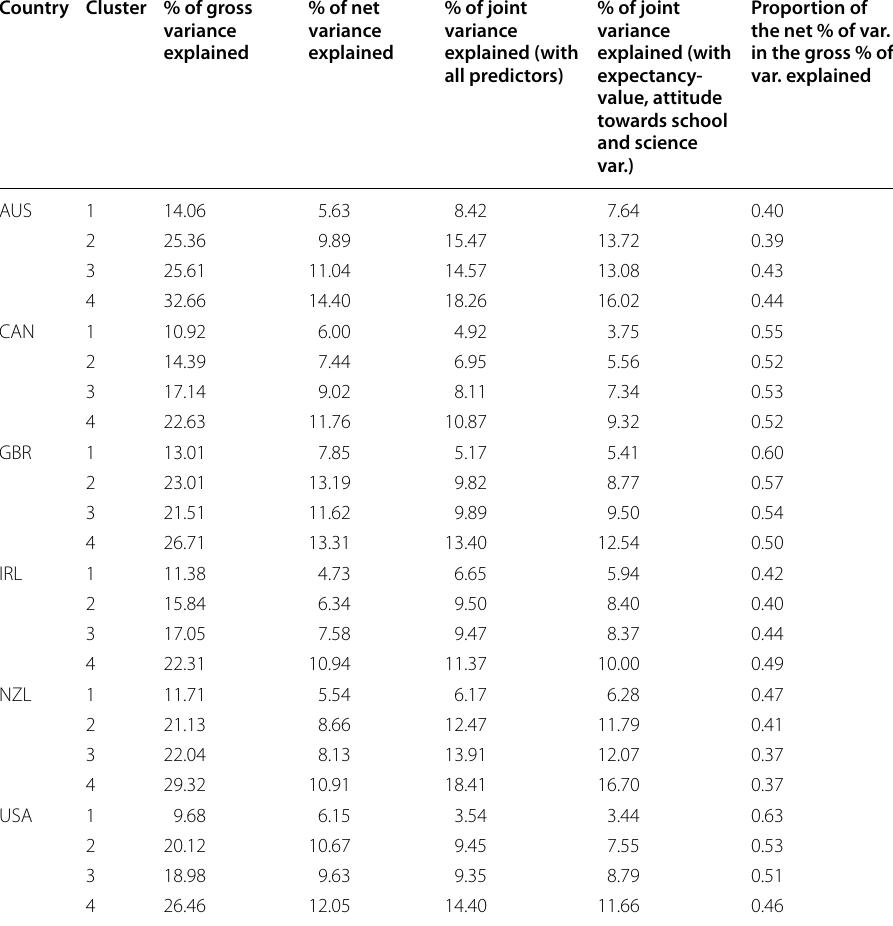
Small discrepancies with the squared correlations of Table 7 are due to the listwise deletion of students with missing values on the covariates used for the analysis of Table 8.